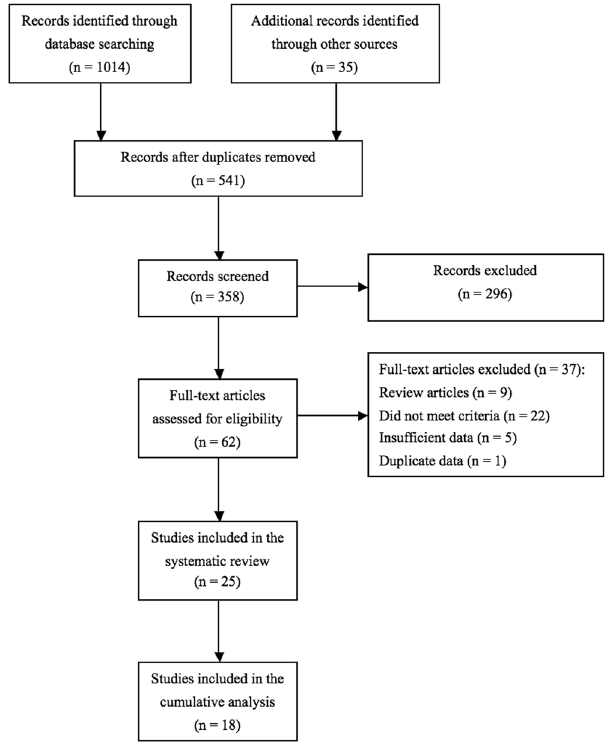
Figure 1. Flow diagram of the systematic